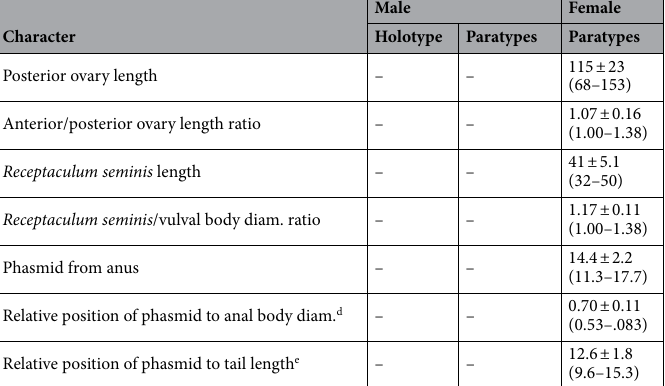
Table 1. Morphometrics of Onthodiplogaster japonica n. gen., n sp. All measurements are in μm and in the form: mean ± s.d. (range). a Tail length including tail spike. b Gonad length including reflex part and vas deferens. c Body diam. is maximum at vulval part in hermaphrodite and female (vulval body diam. = maximum body diam). d Calculated as anus-phasmid distance/anal body diam. e Calculated as 100 × anus-phasmid distance/whole tail